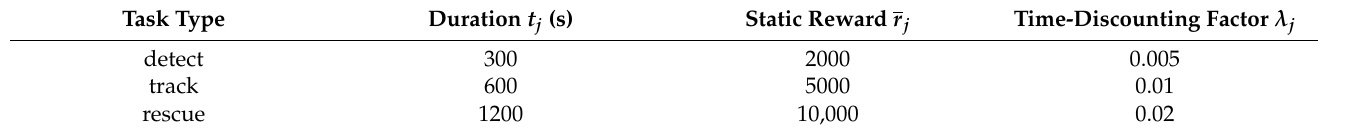
Table 3. Task parameters.